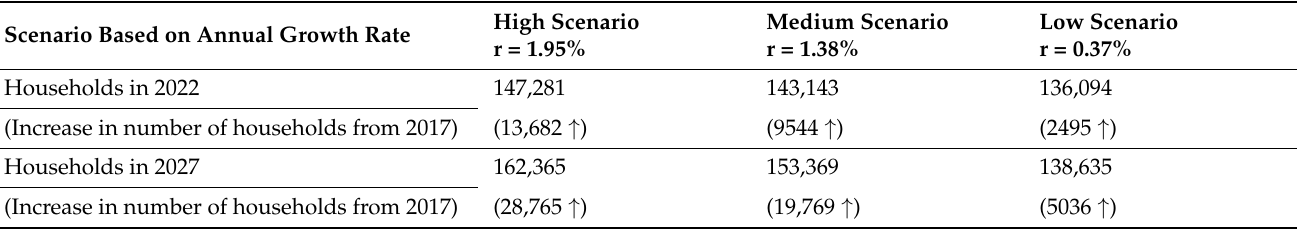
Table 6. Forecasts the household growth rates for local municipality (LM) EEE (Source: Own construction from Stats SA data on the regional explorer (ReX n.d.) platform, time series only available till the year